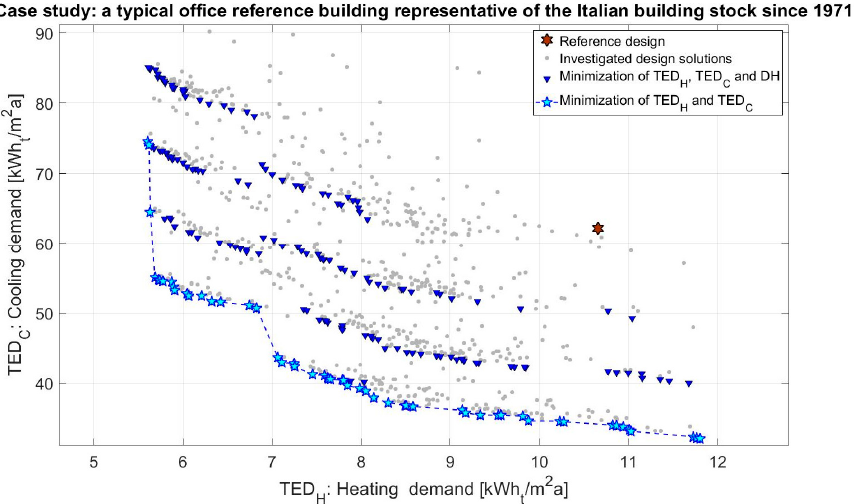
Figure 7. 2-D Pareto front TED heat –TED cool .